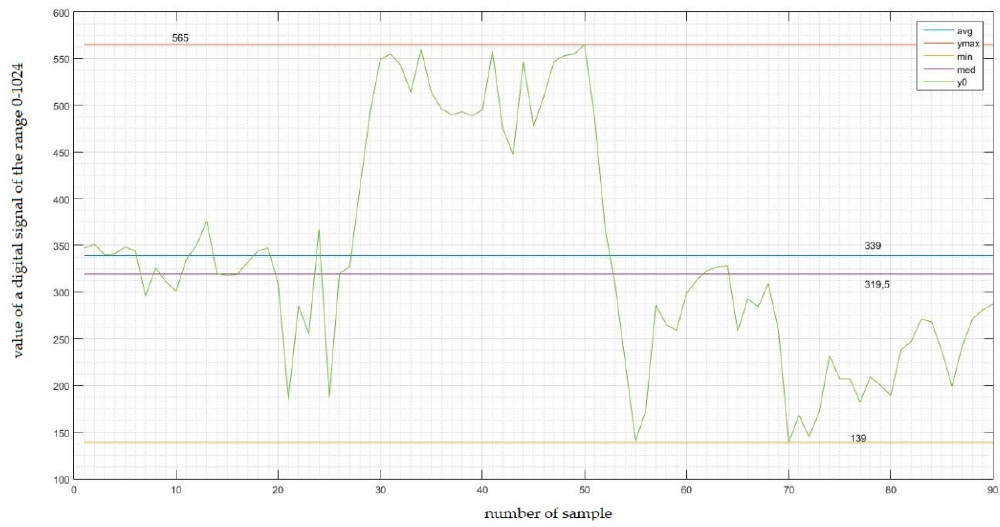
Figure A1. Data from the sensor on a maximally bent thumb.